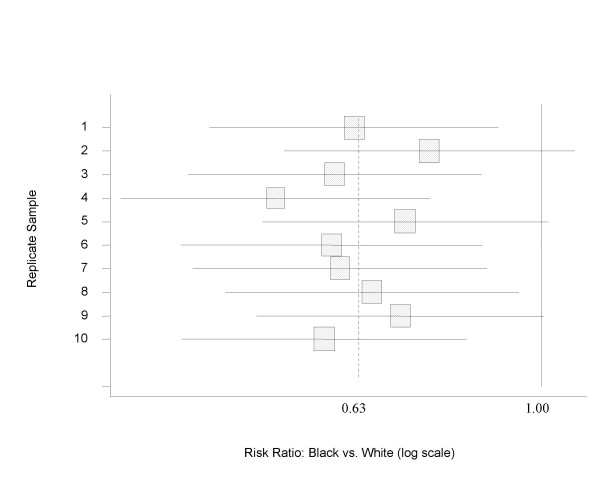
Results of regression analysis for race with the dependent variable initial antibiotics within 8 hours. Forest plot demonstrating the results of the 10 individual conditional logistic regressions models for the dependent variable initial antibiotics within 8 hours after adjusting for severity of illness using the PSI. The presented relative risk with 95% confidence intervals is for the independent variable race (dichotomized into black versus white).